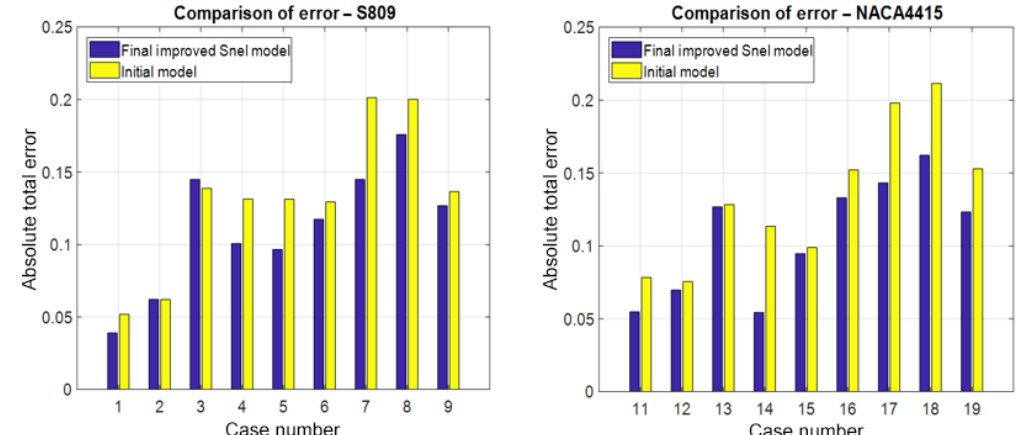
Figure 12. Comparison of the total absolute error of both the initial and improved Snel models.